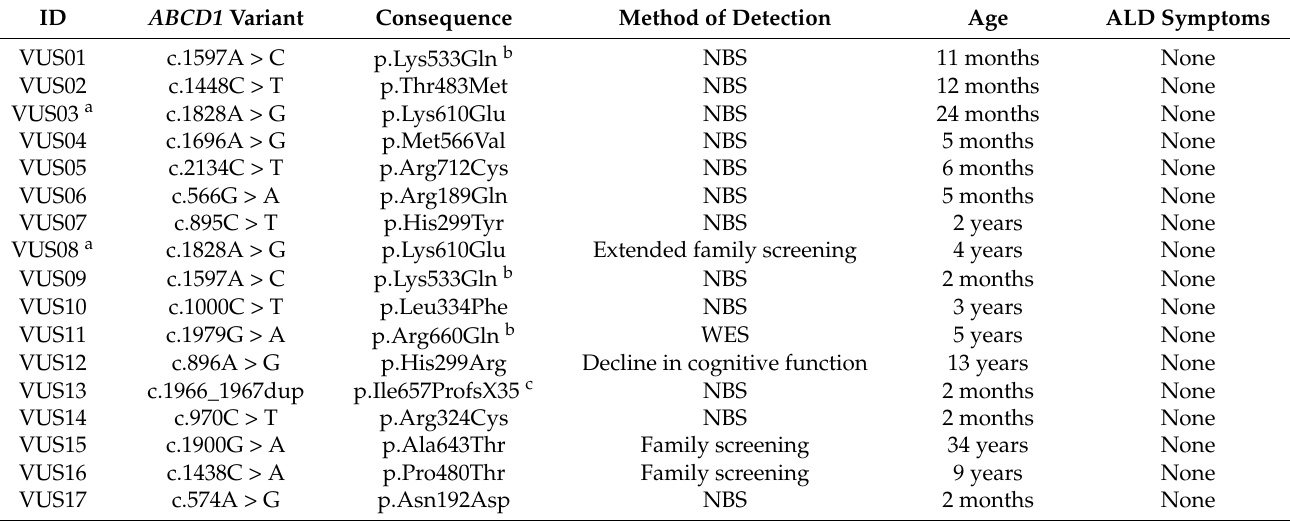
Table 3. Characteristics of individuals with a VUS in ABCD1